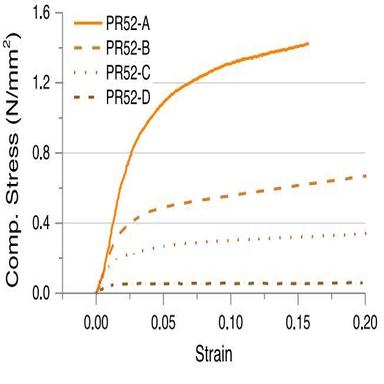
Stress–strain plots (PR52).